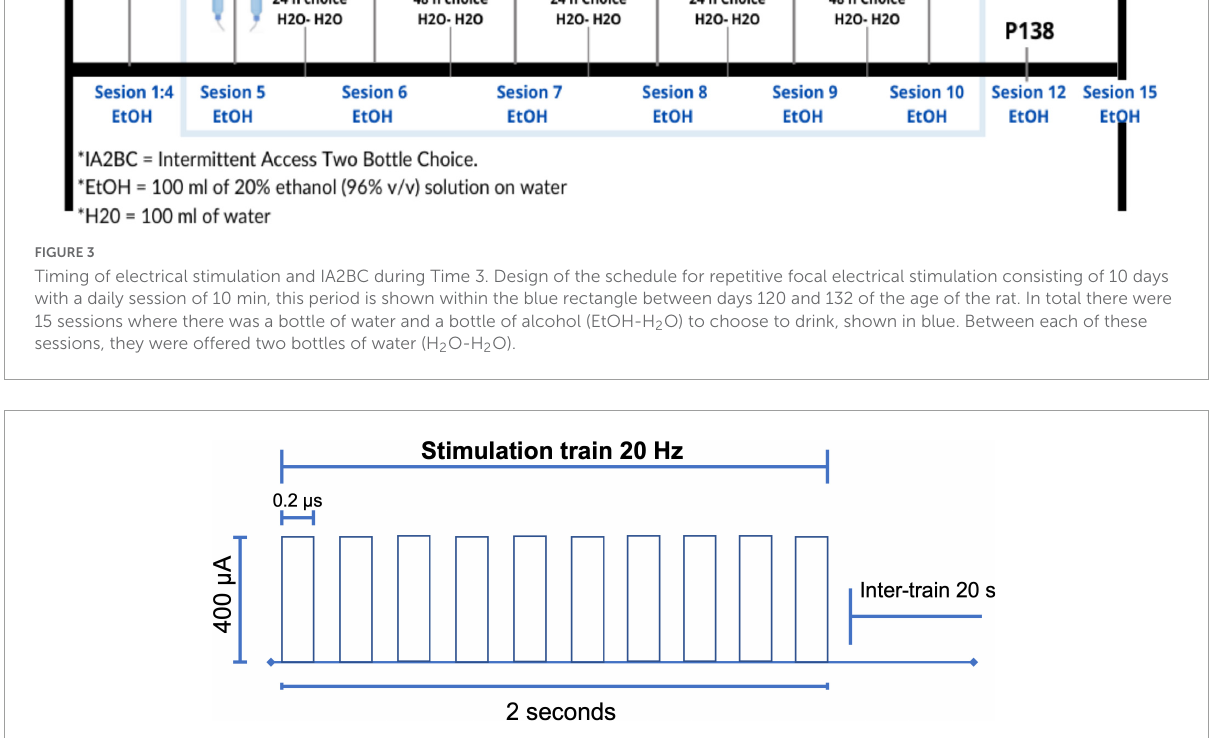
FIGURE4 Electrical stimulation design. With the parameters of 300 pulses (duration = 0.2 ms, intensity = 400 µ A) high frequency of 20 Hz, in trains of 10 pulses every 2 s with an inter-train interval of 20 s. After the choice of the carbon electrode, the research protocol was carried out for